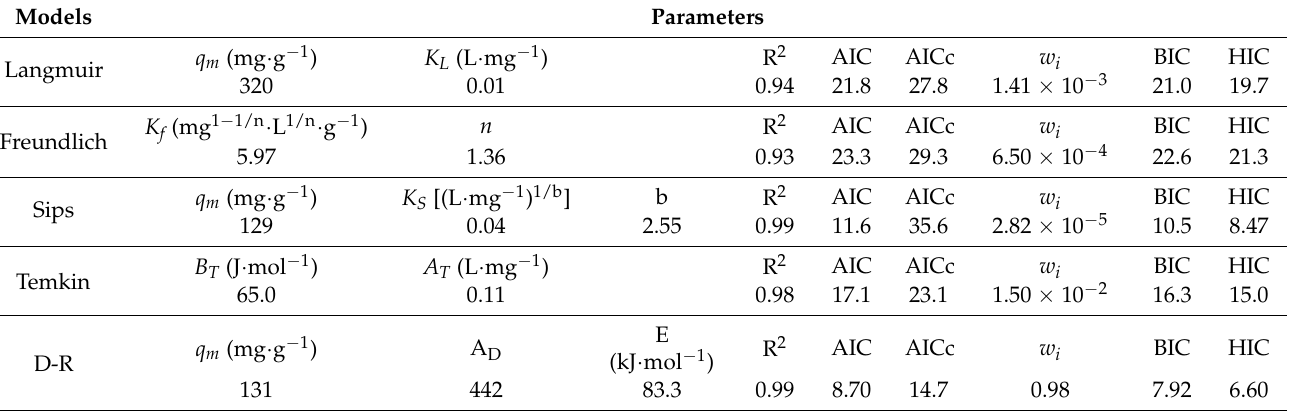
Table 2. Results of the adsorption isotherm